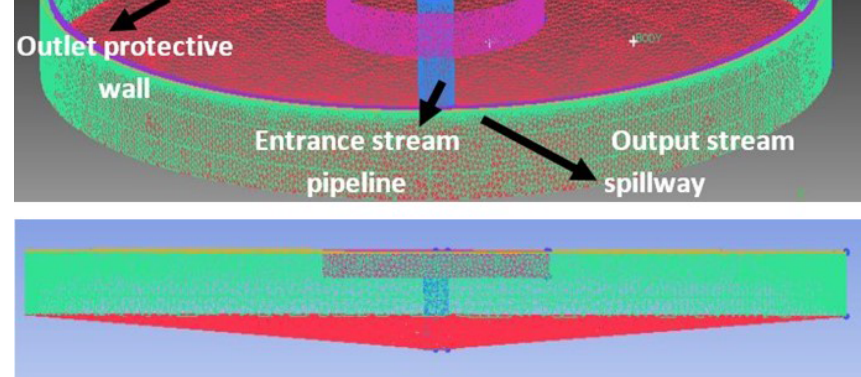
Figure 3. Modeled settling tank.